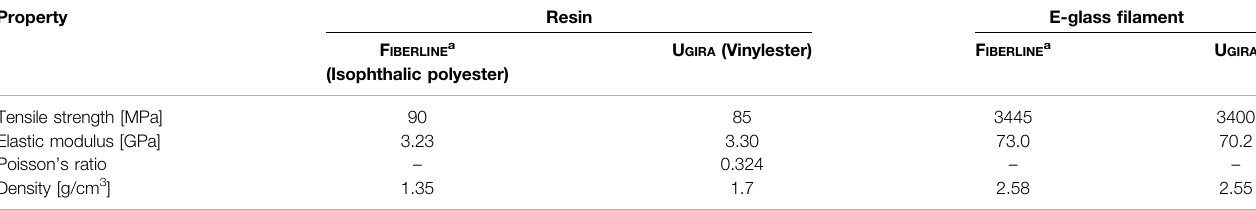
TABLE 1 | Material properties of the GFRP composite constituents. Property